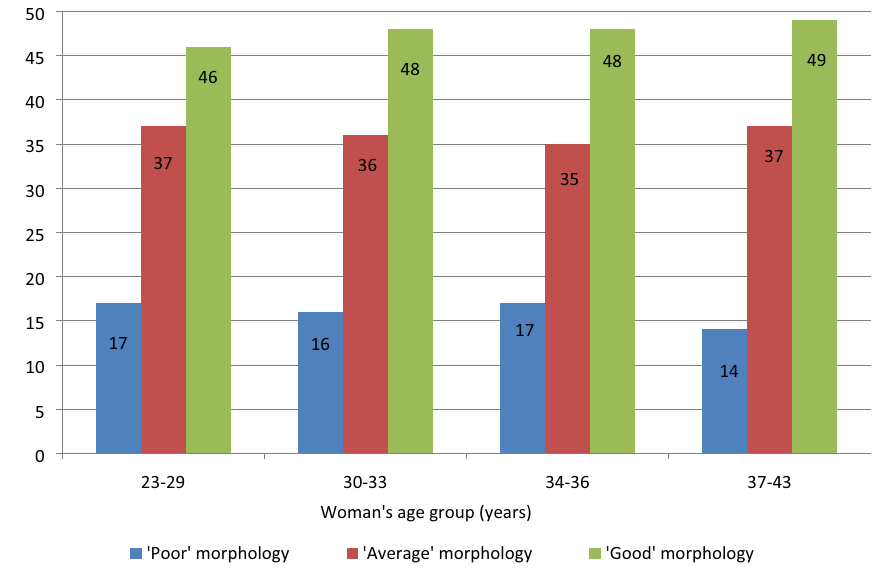
Figure 3. Morphology of D5 blastocysts according to the woman’s age group. Morphological assessment based on the expansion of the blastocoel cavity (B1–B6) and the number and cohesiveness of the inner cell mass (ICM) and trophectoderm (TE) cells 25 . For blastocysts graded as B3–B6, it is possible to assign independent scores to the ICM and TE. For the ICM, grade A indicated a tightly packed ICM with many cells; grade B, a loosely grouped ICM with many cells; and grade C, an ICM with very few cells. For the TE, grade A indicated a TE with many cells forming a cohesive epithelium; grade B, a TE with few cells forming a loose epithelium; and grade C, a TE with very few cells. ‘Poor’morphology: B3–B6, CC. ‘Average’ morphology: B3–B6, AC/CA/BC/ CB). ‘Good’morphology (B3–B6, AA/AB/BA/BB). Data were not significantly different ( p > 0.05).